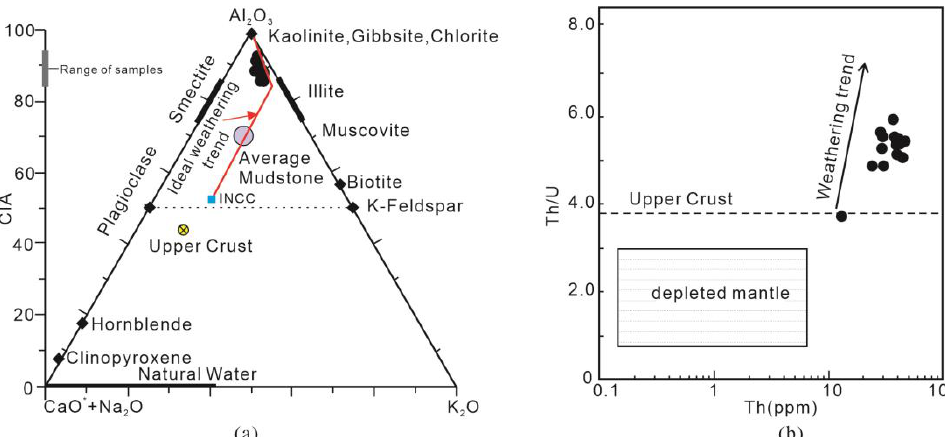
Figure 10. Relative abundances of selected major and trace elements of Oil shales, showing the weathering status of its source rocks: ( a ) Al 2 O 3 −(Na 2 O + CaO*) − K 2 O ternary diagram (after Condie et al., 1992) and ( b ) Th/U versus Th plot (after McLennan et al., 1993). The Th/U ratio is another parameter that can be used to reflect weathering intensity.